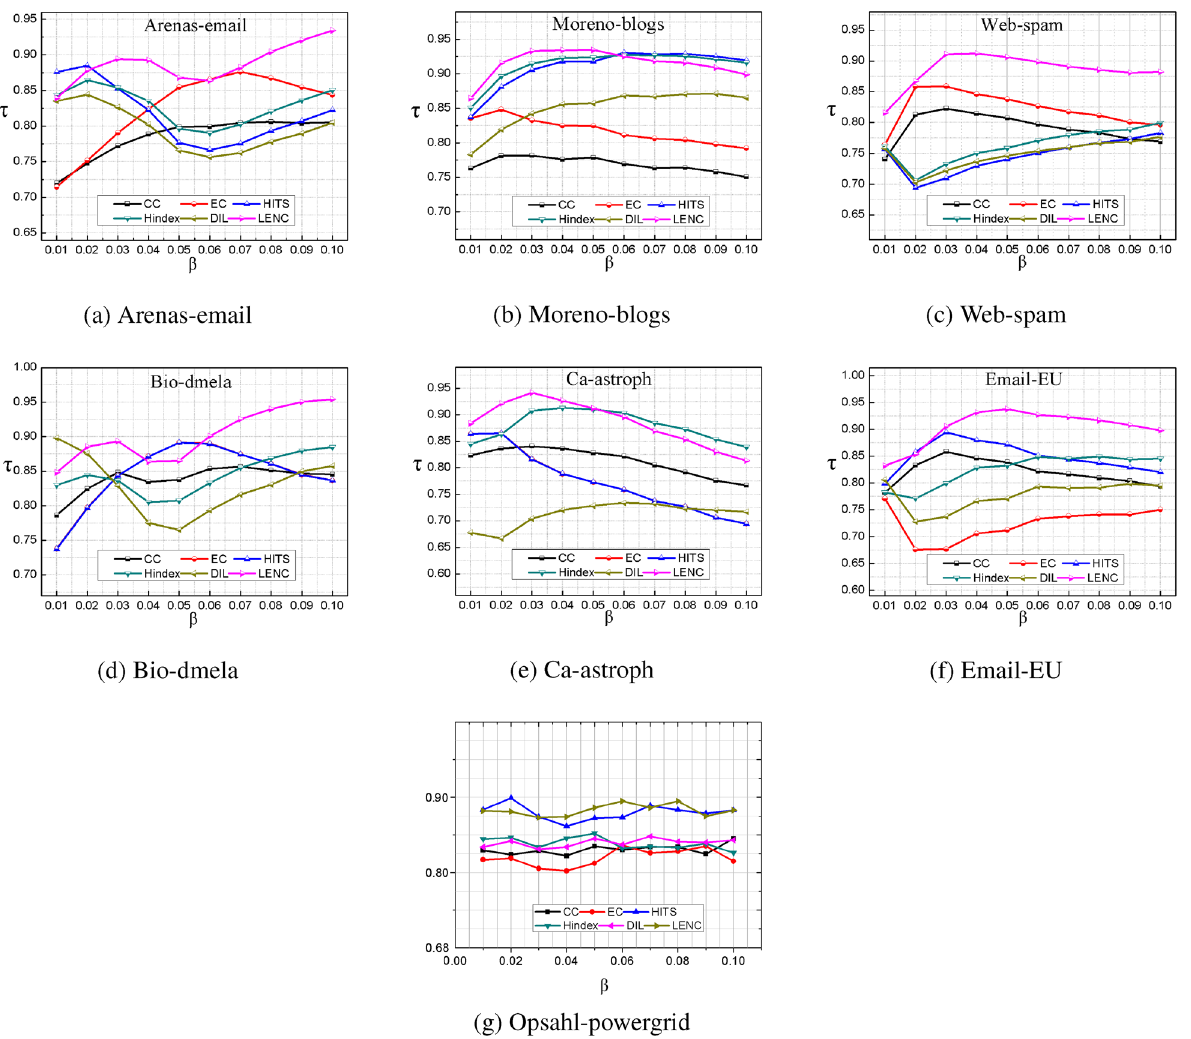
Figure 7. Kendall coefficient comparison under different infection probability